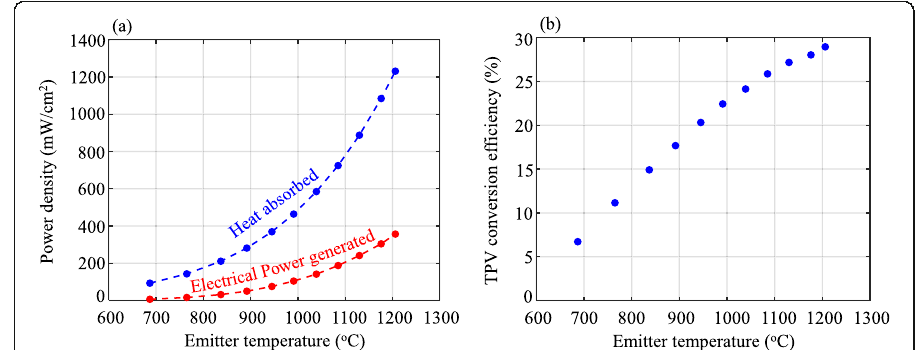
Fig. 5 Record thermophotovoltaic efficiency. Measured total incident thermal radiation absorbed, and the maximum electrical power generated by the thermophotovoltaic cell at those emitter temperatures, are shown in ( a ). Power conversion efficiency, the fraction of the absorbed heat that gets converted to the electrical power, is given in ( b